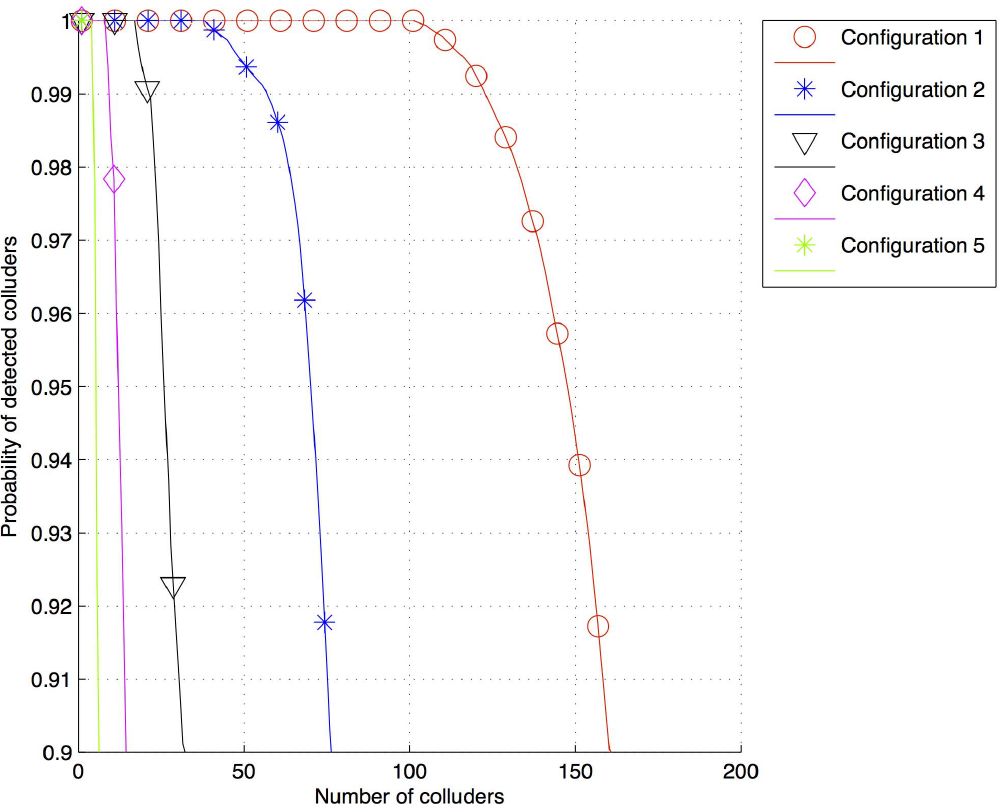
Figure 5. Probability of detected colluders after a collusion attack for fingerprints generated with the configurations 1, 2, 3, 4 and 5 in Table 3 and P w ~ 1 = 6 .